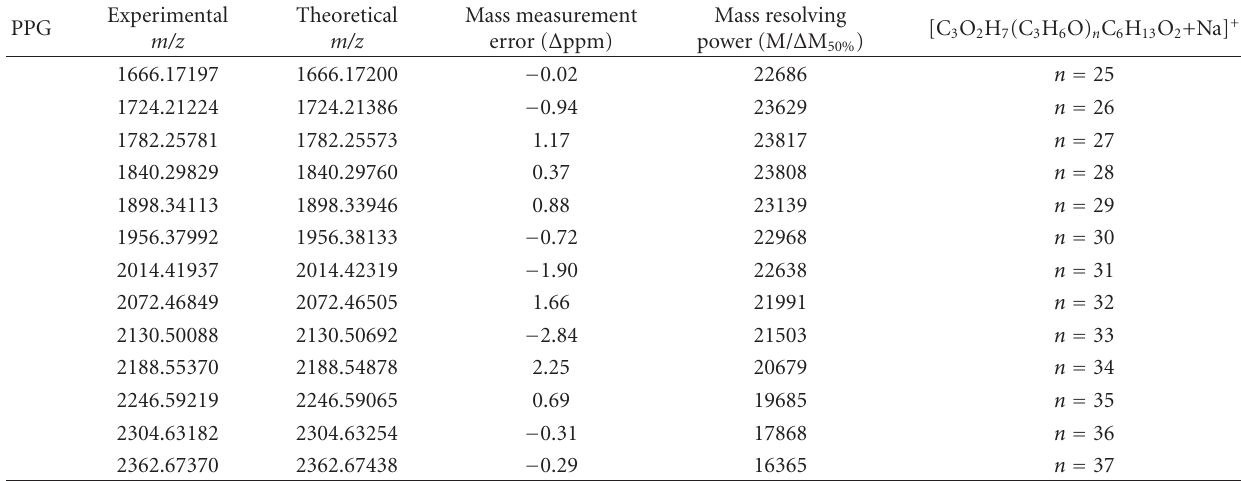
Table 2: PPG standards identified using paper spray mass spectrometry. The PPG mass spectrum was obtained with excitation and detection frequency range of 1.5